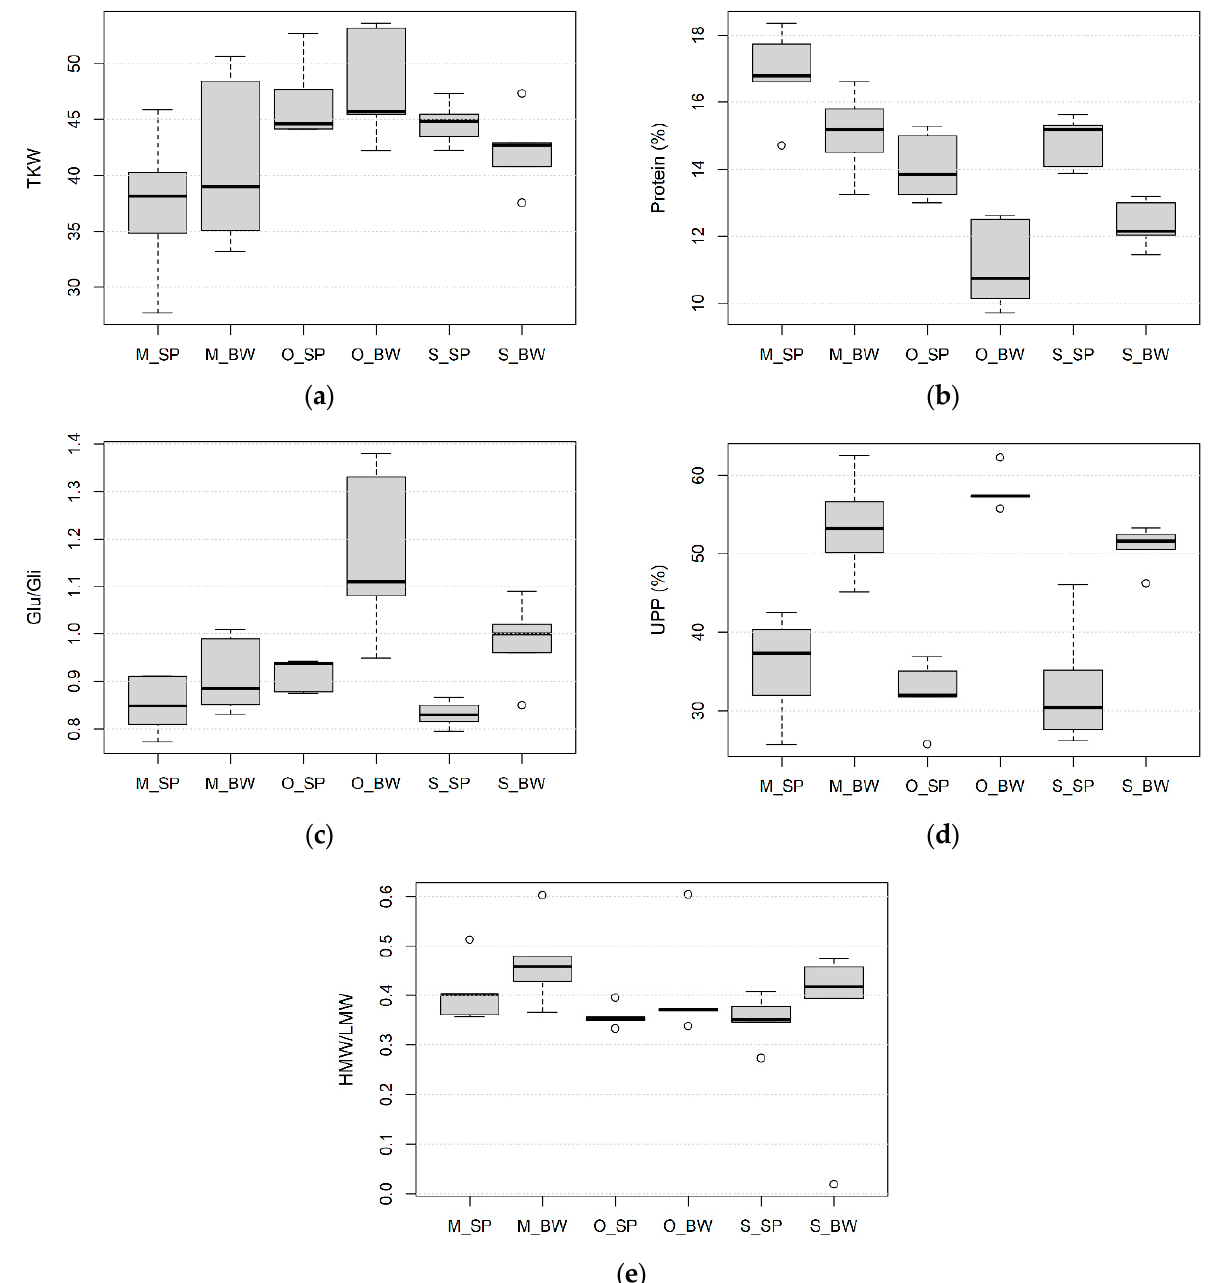
Figure 2. Boxplots for ( a ) TKW—thousand ‐ kernel weight, ( b ) protein content, ( c ) Glu/Gli—the quantitative ratio of glutenins to gliadins, ( d ) UPP%—the percentage of unextractable polymeric proteins, ( e ) HMW/LMW—the ratio of high molecular weight and low molecular weight gluten subunits; SP—spelt wheat, BW—bread wheat, M—conventional growing site in Martonvásár, Hungary, O—organic growing site in Hungary, S—conventional growing site in Serbia; minimum value excluding outliers—shown by the line at the end of the bottom whisker; the first lower quartile (25th percentile)—shown by the lower end of the box; median—shown by the horizontal line inside the box; the third upper quartile (75th percentile)—shown by the upper end of the box; maximum value excluding outliers—shown by the line at the end of the upper whisker; outliers—shown by the empty circles.